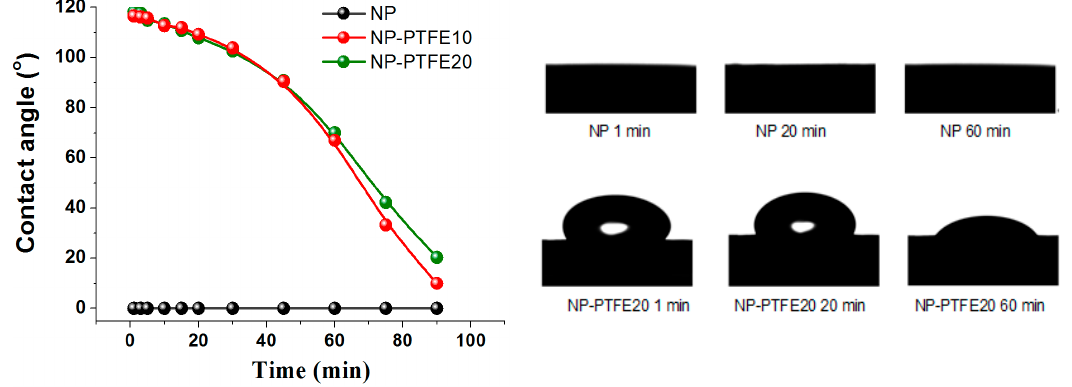
Figure 11. The contact angle of the new pressboard, new pressboard deposited PTFE for 10 min and 20 min.